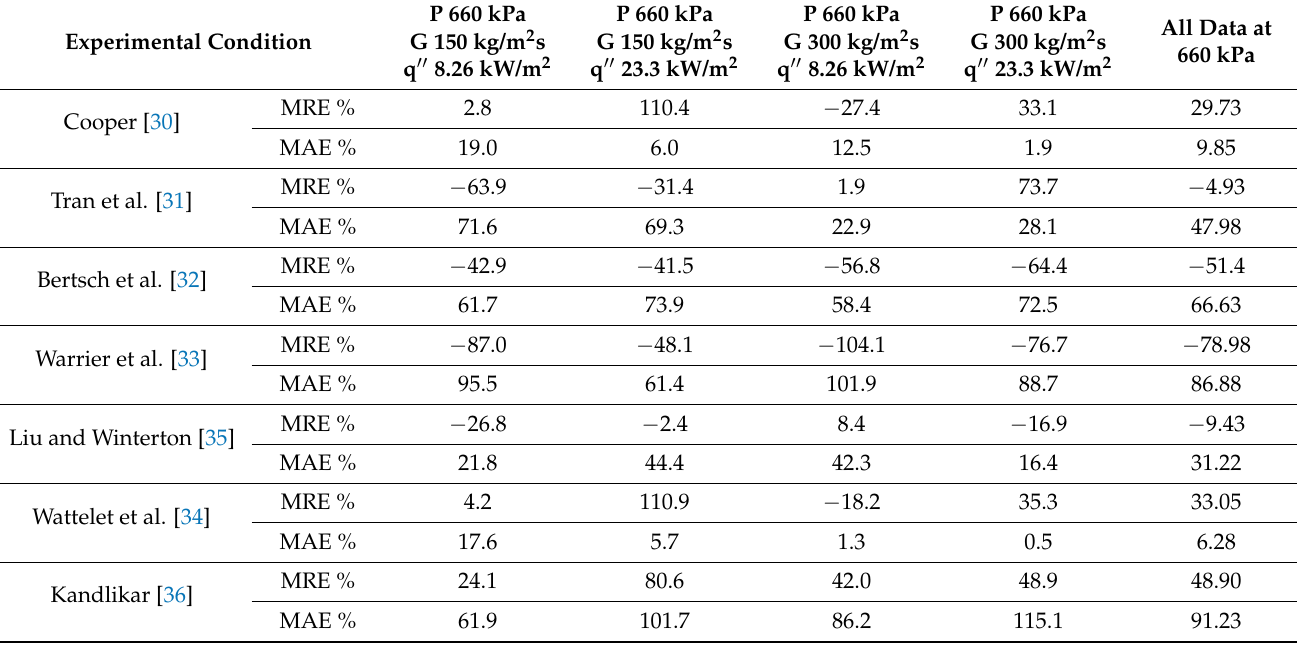
Table 8. Statistical analysis of the comparison between experimental heat transfer coefficient and prediction models at saturation pressure of 660